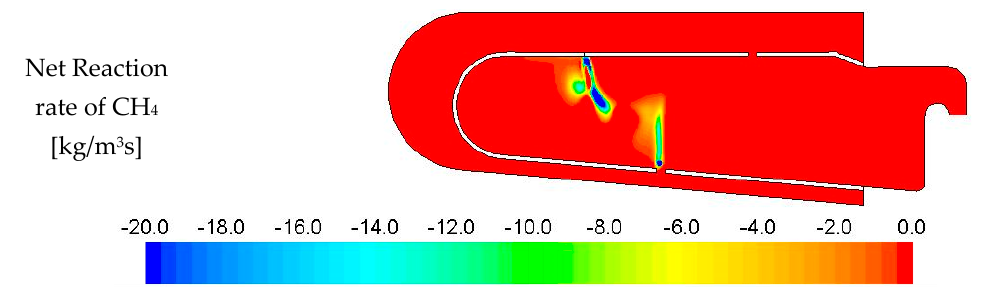
Figure 23. Mass fractions distributions of the main species for each fuel.